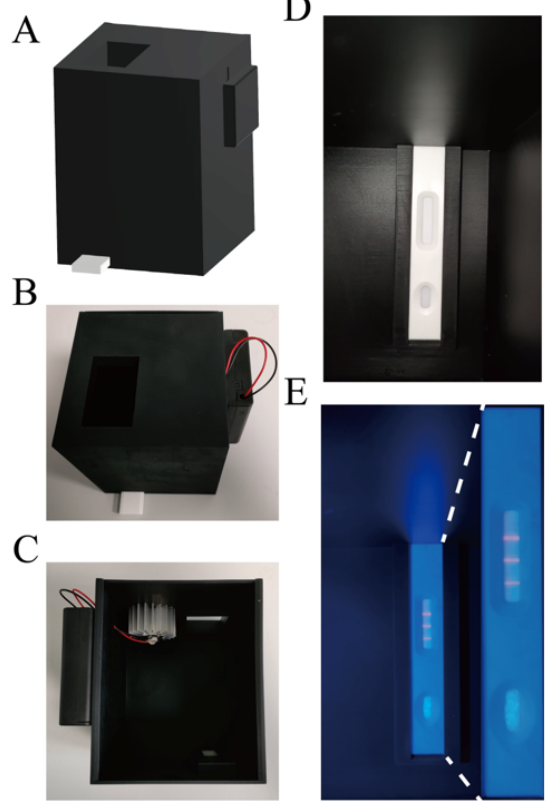
Figure 7. The device supports the FluB/SARS-CoV-2 QDFM ICTS. ( A , B ) Structure of the device. ( C ) The position of the ultraviolet LED inside the device. ( D , E ) The application of the device.